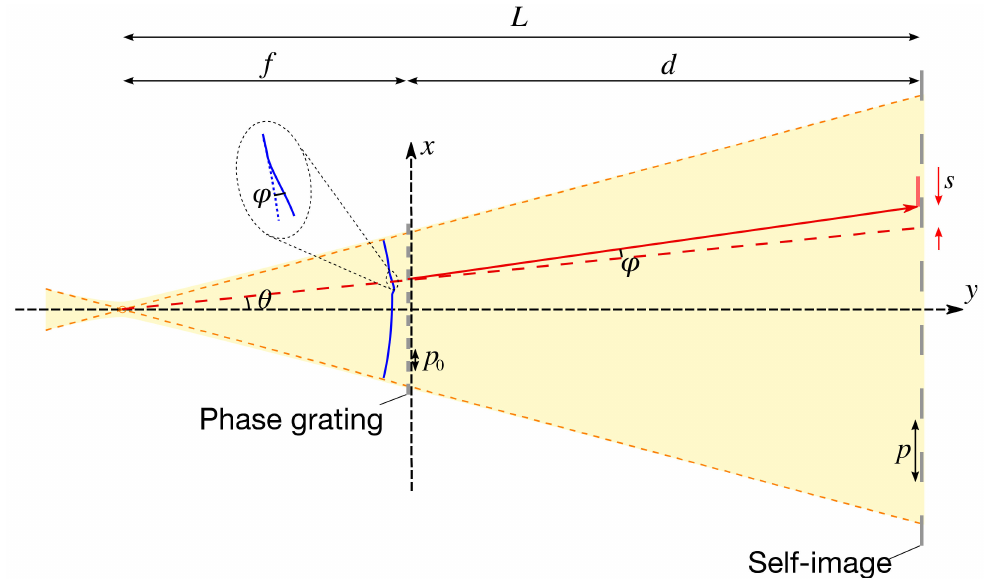
Figure 1. Schematic illustration of the single-grating interferometer and ray trajectory with a local wavefront